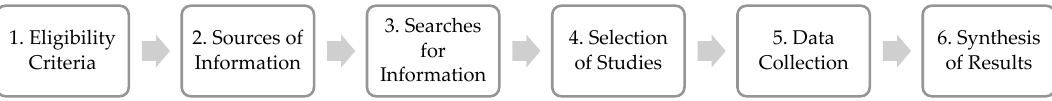
Figure 1. Steps for the review of the literature (Torres et al., 2020) [20].